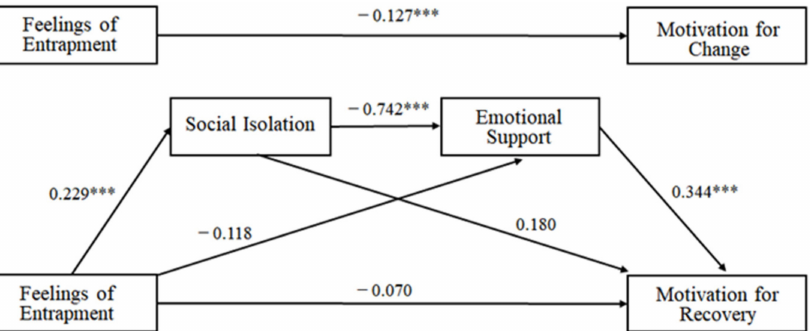
Figure 2. Examined double mediation model of social isolation and emotional support on feelings of entrapment and motivation for recovery of alcoholic patients (*** p < 0.001).